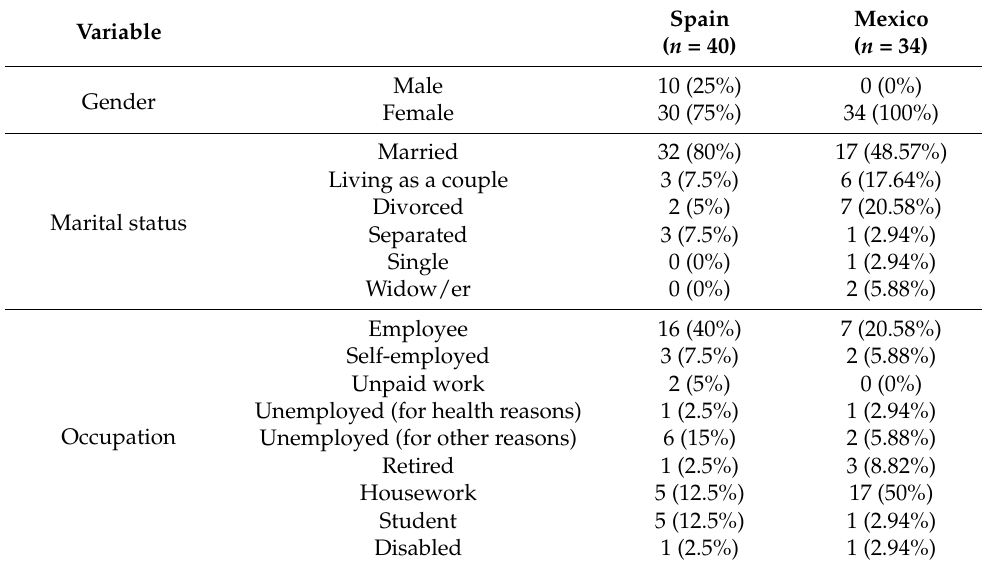
Table 1. Distribution of sociodemographic and medical variables.